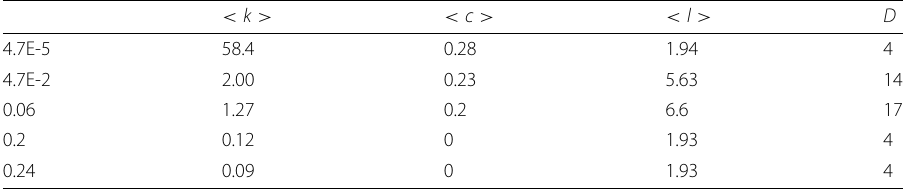
Table 2 Statistical properties of Rio de Janeiro’s mobility network